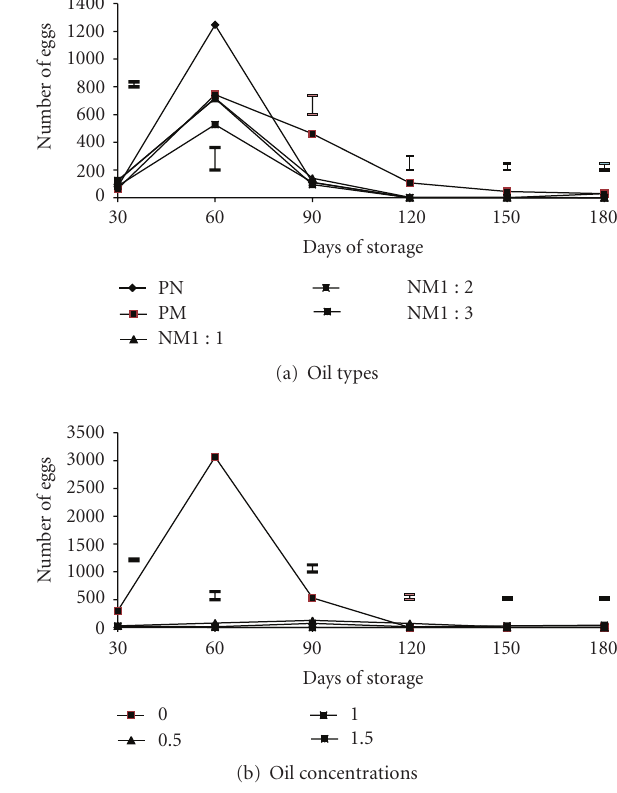
Figure 1: E ff ect of oil types and concentrations on number of eggs laid by C. maculates in stored cowpea. Vertical lines are LSD bars at P = . 05.